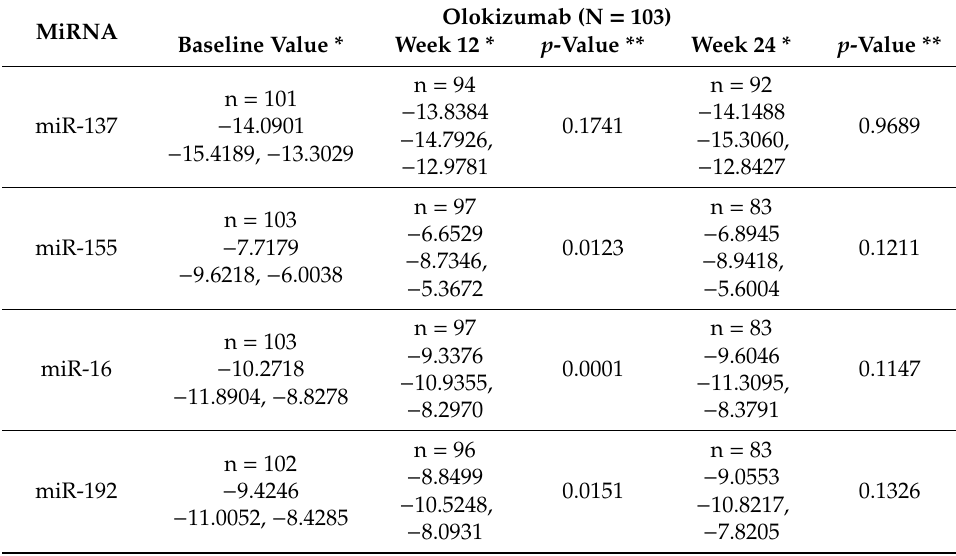
Table 4. Relative expression of miRNAs at weeks 12 and 24 in comparison with